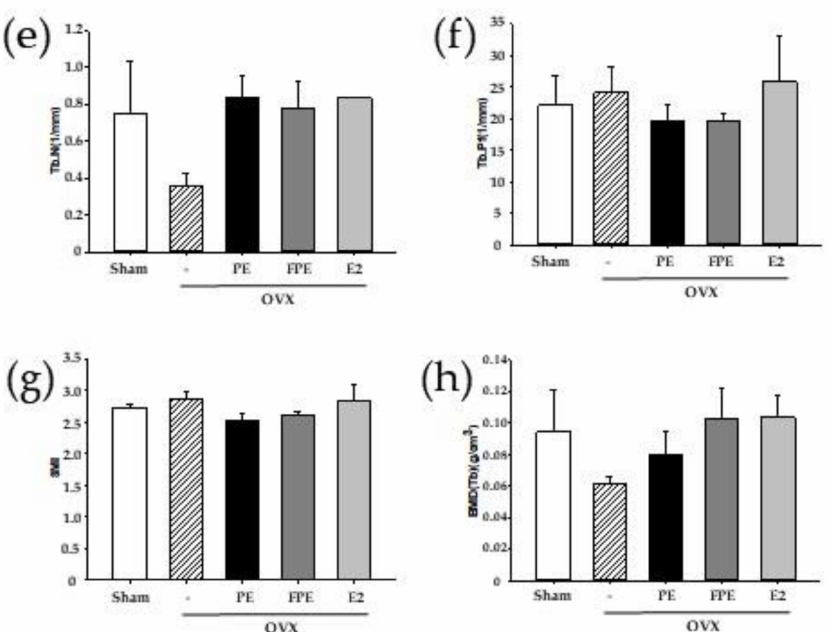
Figure 8. Micro-CT analysis of the trabecular bone. ( A ) Micro-CT images of the trabecular bone of the femur; ( a ) sham; ( b ) OVX; ( c ) OVX + PE 100 mg/kg; ( d ) OVX + FPE 100 mg/kg; ( e ) E 2 ; ( B ) ( a ) BV/TV; ( b ) BS/BV; ( c ) Tb.Th; ( d ) Tb.Sp; ( e ) Tb.N; ( f ) Tb.Pf; ( g ) SMI; ( h ) BMD of OVX-induced mice treated PE, FPE, and E 2